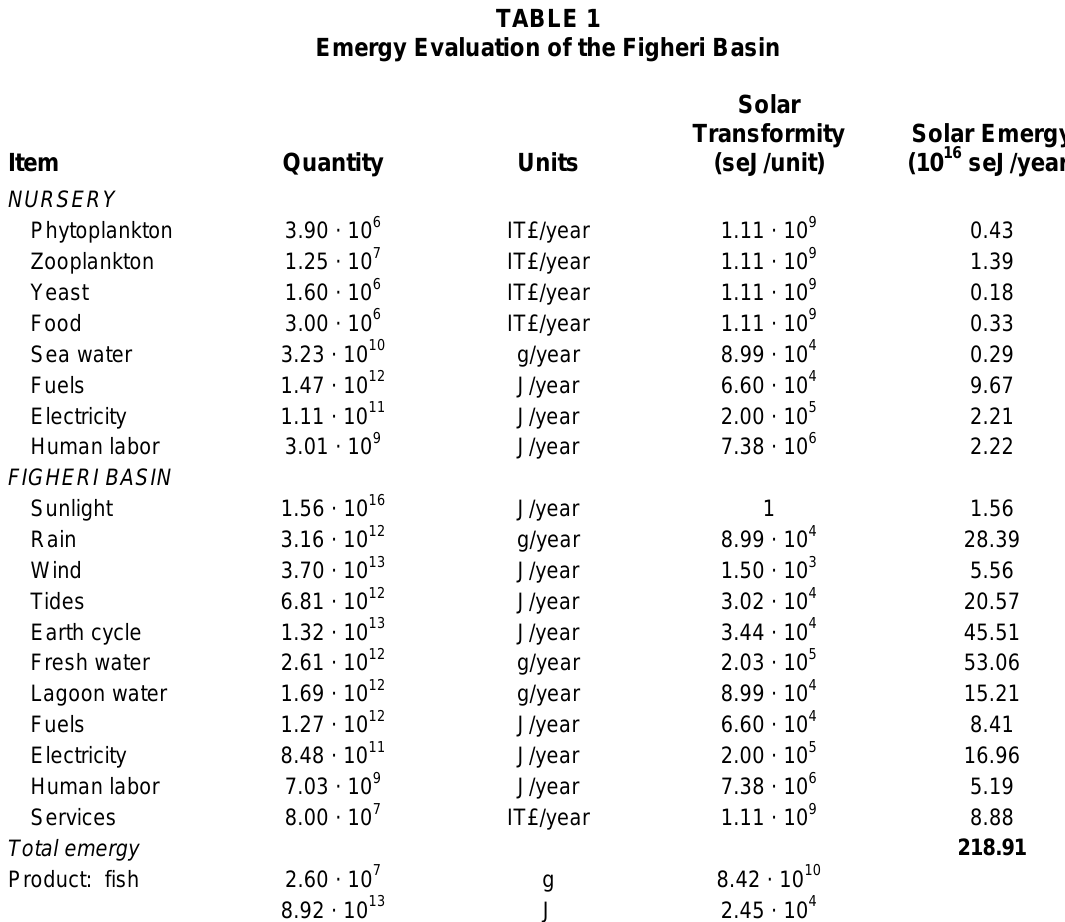
Emergy Evaluation of the Figheri